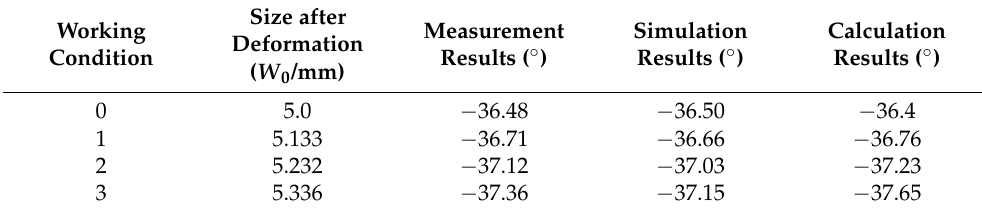
Table 17. Maximum radiation direction of the Mode 4 antenna under four working